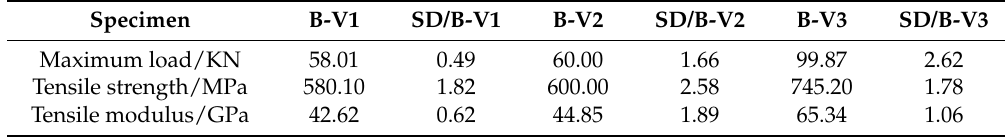
Table 2. The main tensile properties of 3D braided